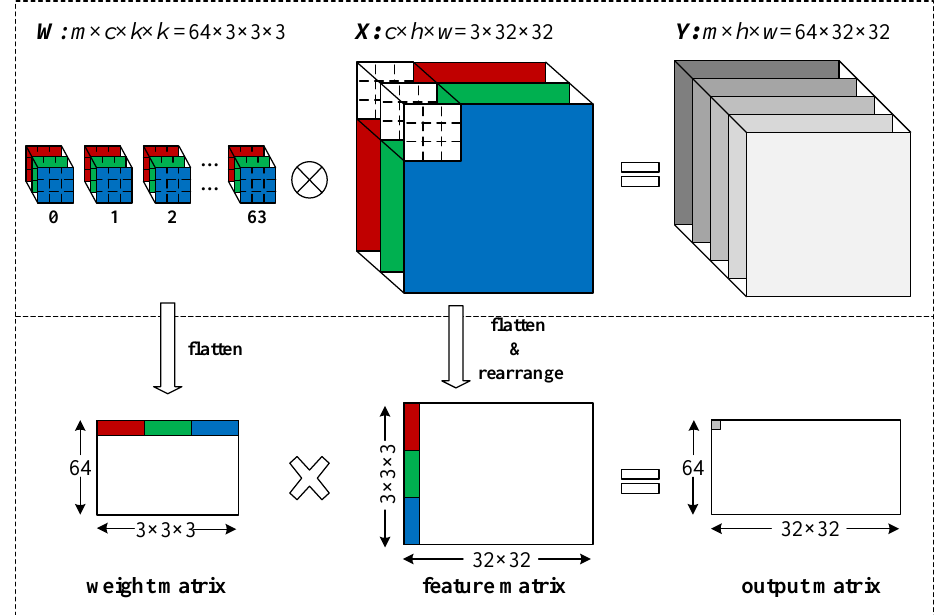
Figure 2. Mapping convolutions to matrix multiplication